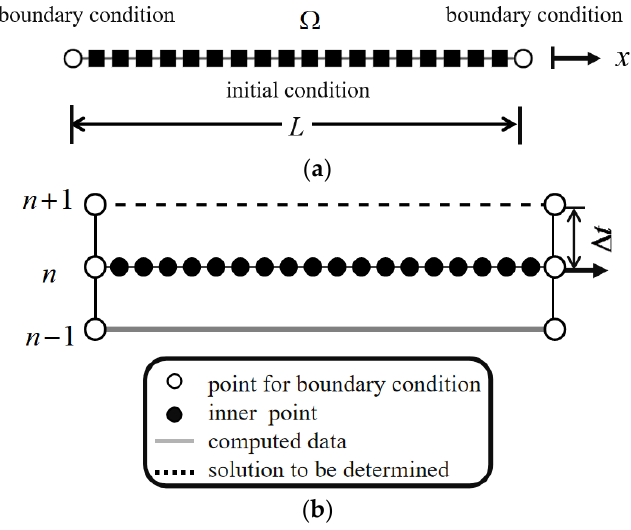
Figure 1. Illustration of the one-dimensional time marching method. ( a ) Domain for discretization. ( b ) Time marching method.